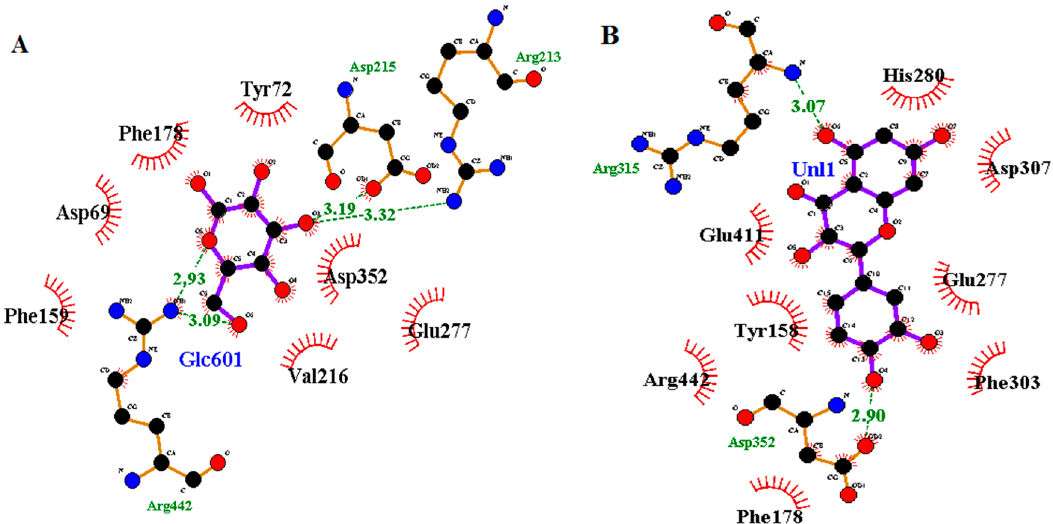
Figure 6. The 2D diagram of the control docking ( A ) and the positive control (quercetin) docking ( B ), with the red lashes representing the residues involved in hydrophobic interactions, while the green dotted lines represent the hydrogen bonds.